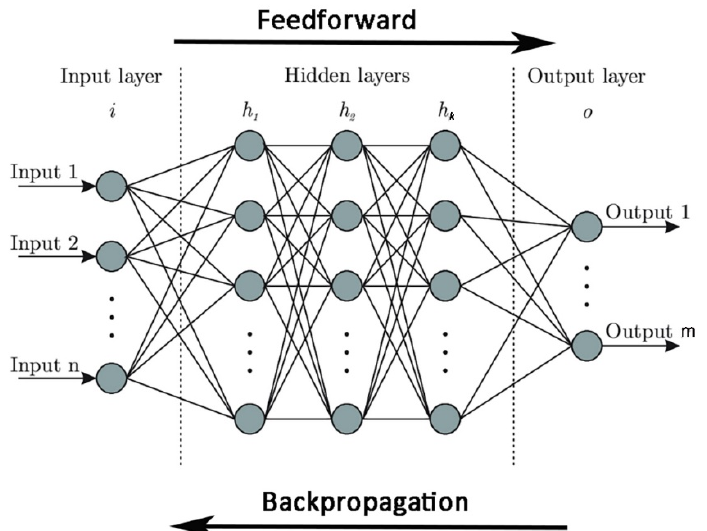
Figure 4. Dense feedforward deep neural network.